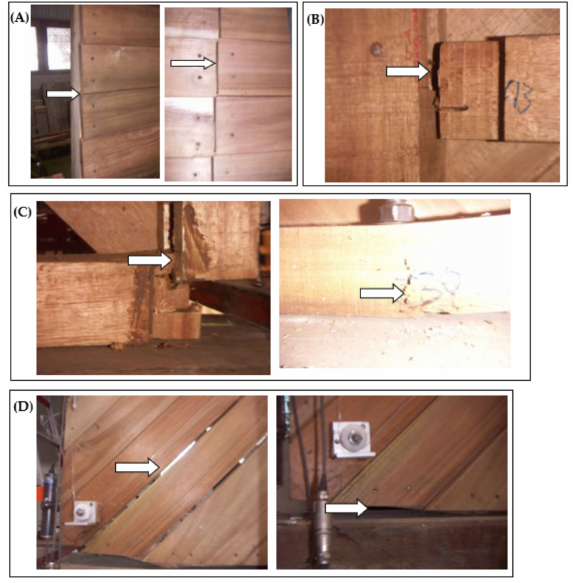
Figure 10. Damage that occurs in CLT-mangium shear wall components. ( A ) = Shift between tongue and groove board panels on components frame shear walls lumber sheathing horizontal type (straight sheeting) due to lateral forces; ( B ) = Detachment of the shear wall frame at the joint points; ( C ) = Structural damage due to fracture and detachment of the shear wall frame at the joint points; ( D ) = Damage in the form of the formation of gaps between the arrangement of panels of diagonal boards at the bottom due to the imposition of lateral